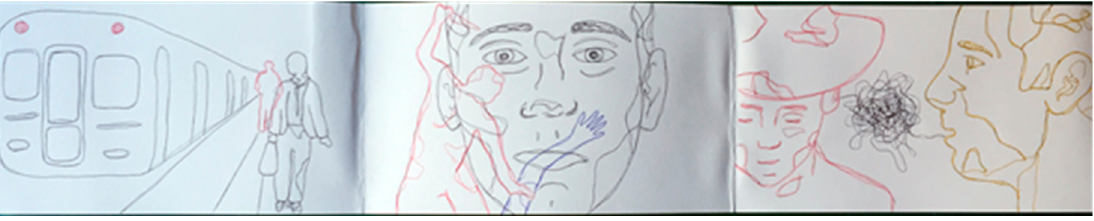
Figure 2. Exercises in Style, texticule: Blurb , developed in the Visual Design class 2016–2017 by Edoardo